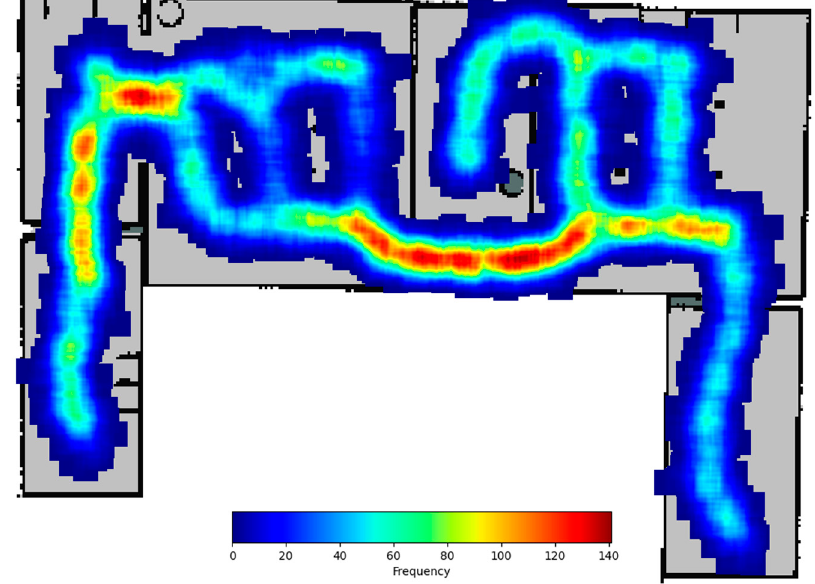
Figure 6. Map and heatmap of generated obstacles using a linear scale.